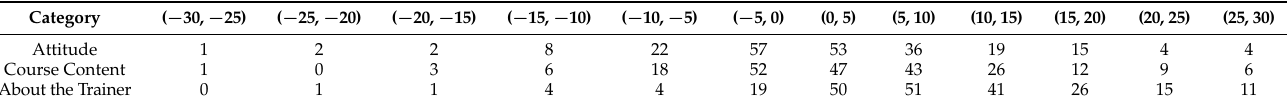
Table 2. Number of Students in each Category and Fulfillment Score